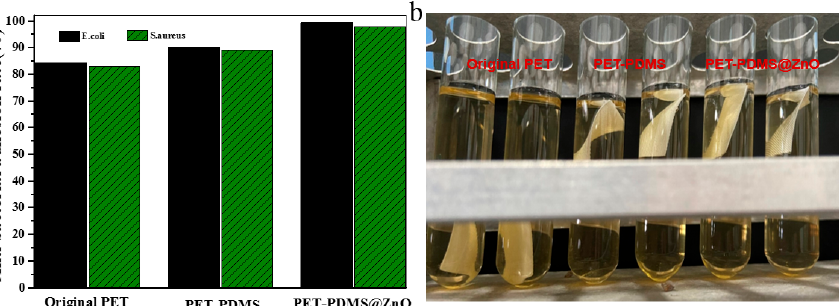
Figure 6. Antibacterial adhesion tests. ( a ) Antibacterial adhesion rate of different fabric, with E. coli and S. aureus bacteria; ( b ) The state of different PET fabrics in liquid culture medium.